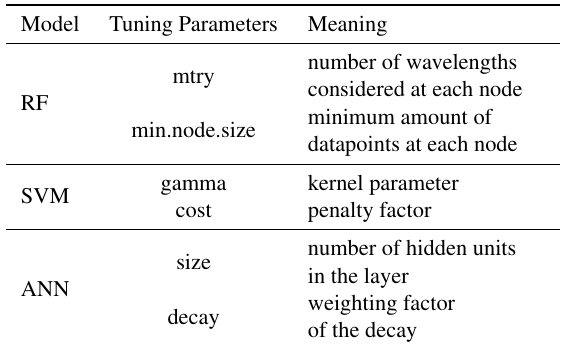
Table 2. Hyperparameters of the three regression models which are adjusted by a grid